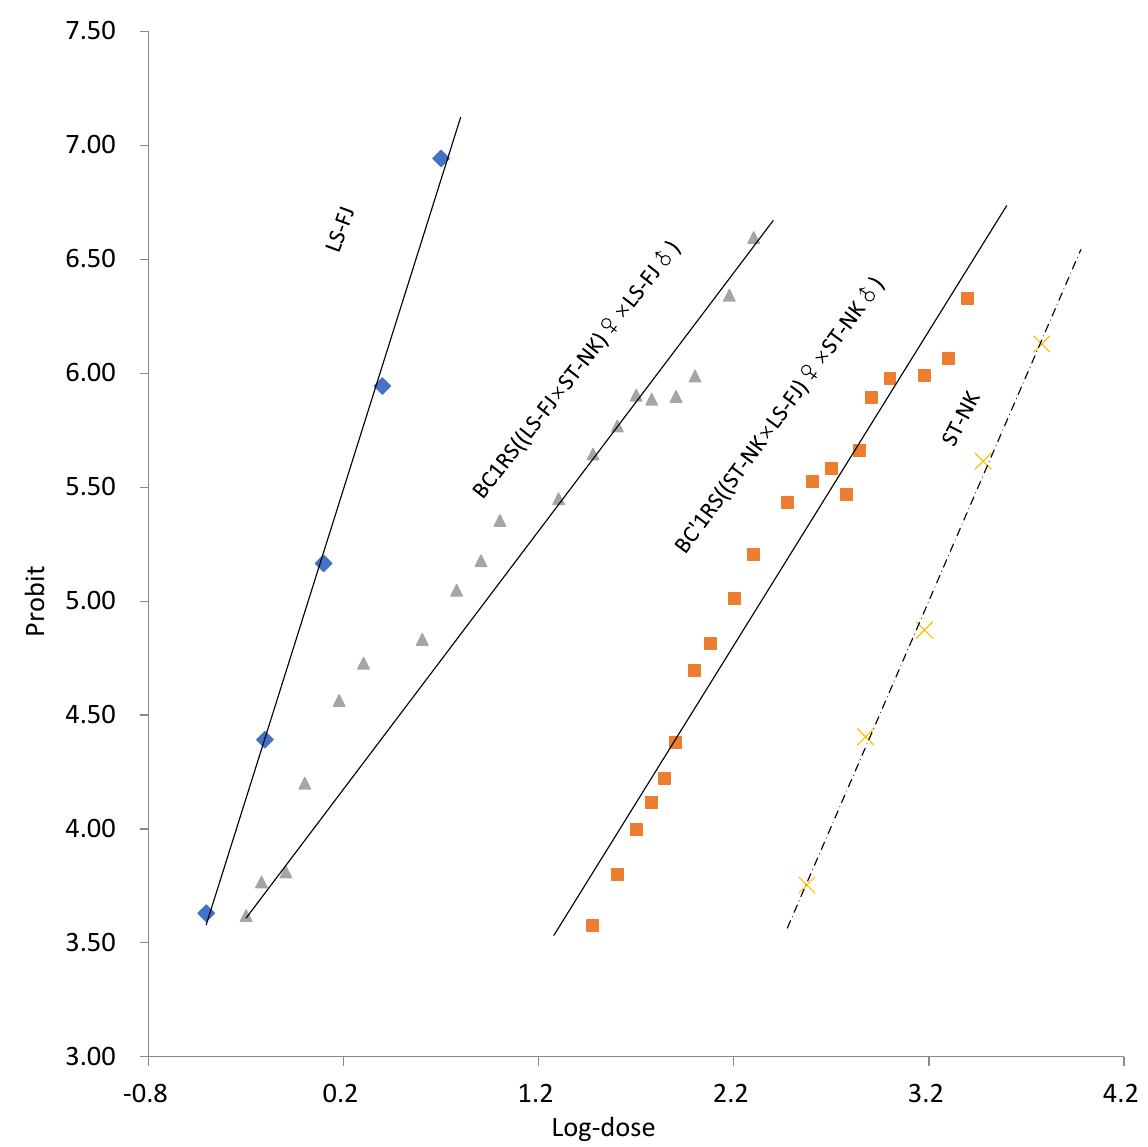
Figure 4. LD-P lines of actual mortality and expected mortality for backcross BC 1SR and BC 1RS of Panonychus citri.